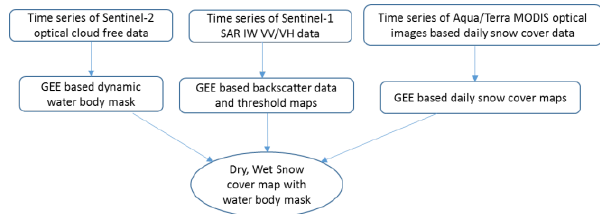
Figure 3: SAR based snow cover mapping methodology